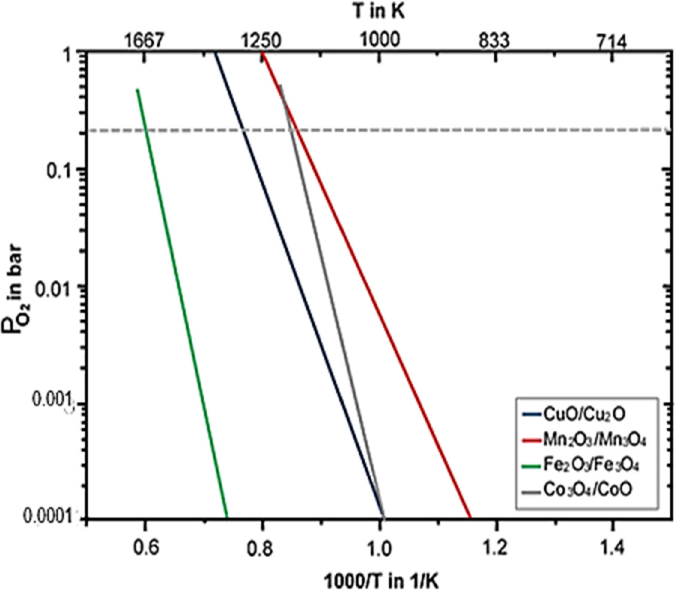
Figure 6. Variation of temperature with oxygen partial pressures for Cu, Mn, Fe, and Co oxides [103].